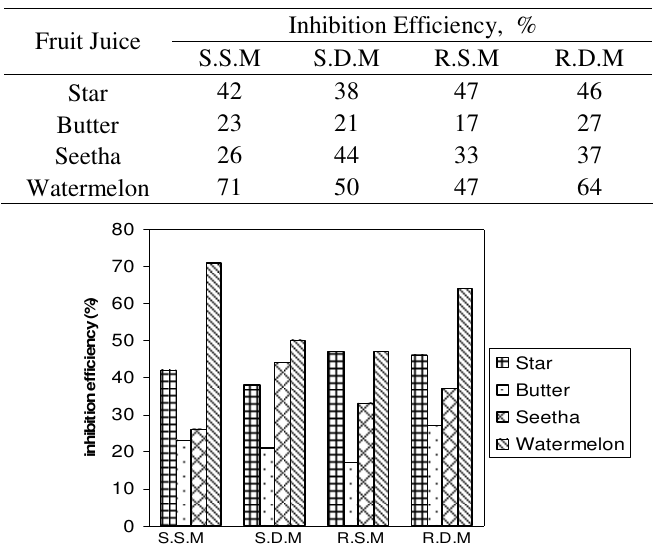
Table 2. Inhibition of calcium phosphate mineralization by fruit juice.